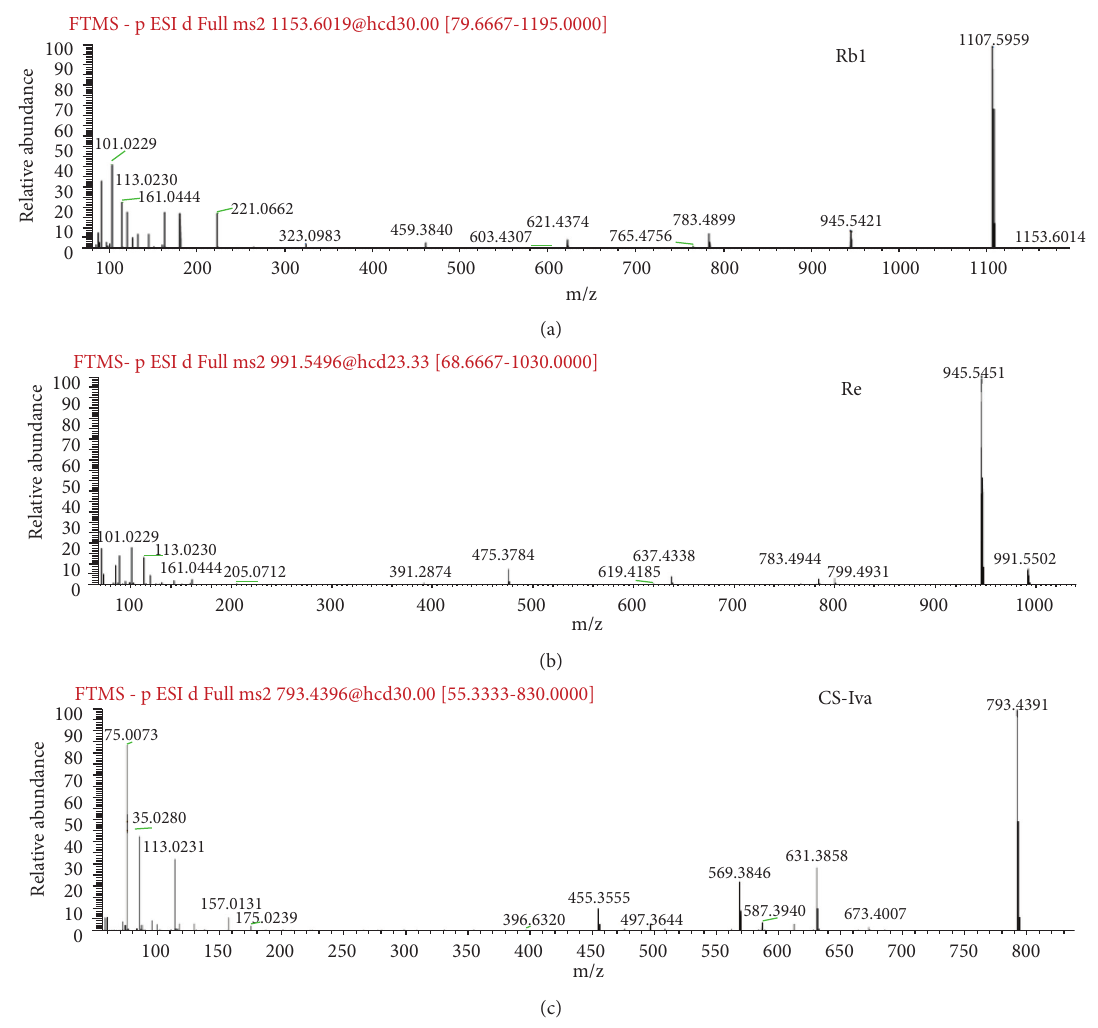
Figure 2: The MS/MS spectrum of ginsenoside-Rb1 (a), ginsenoside-Re (b), and ginsenoside-CS-Iva